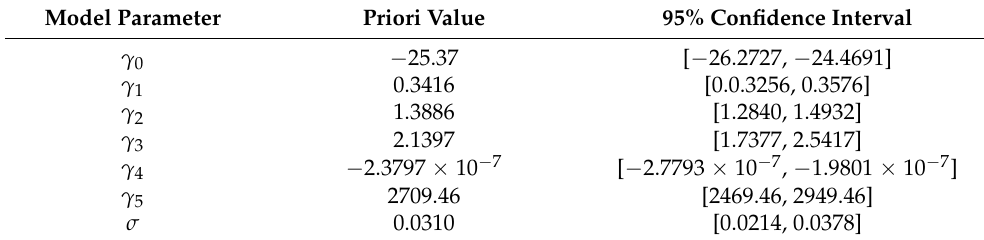
Table 4. Prior value and 95% confidence interval of each model